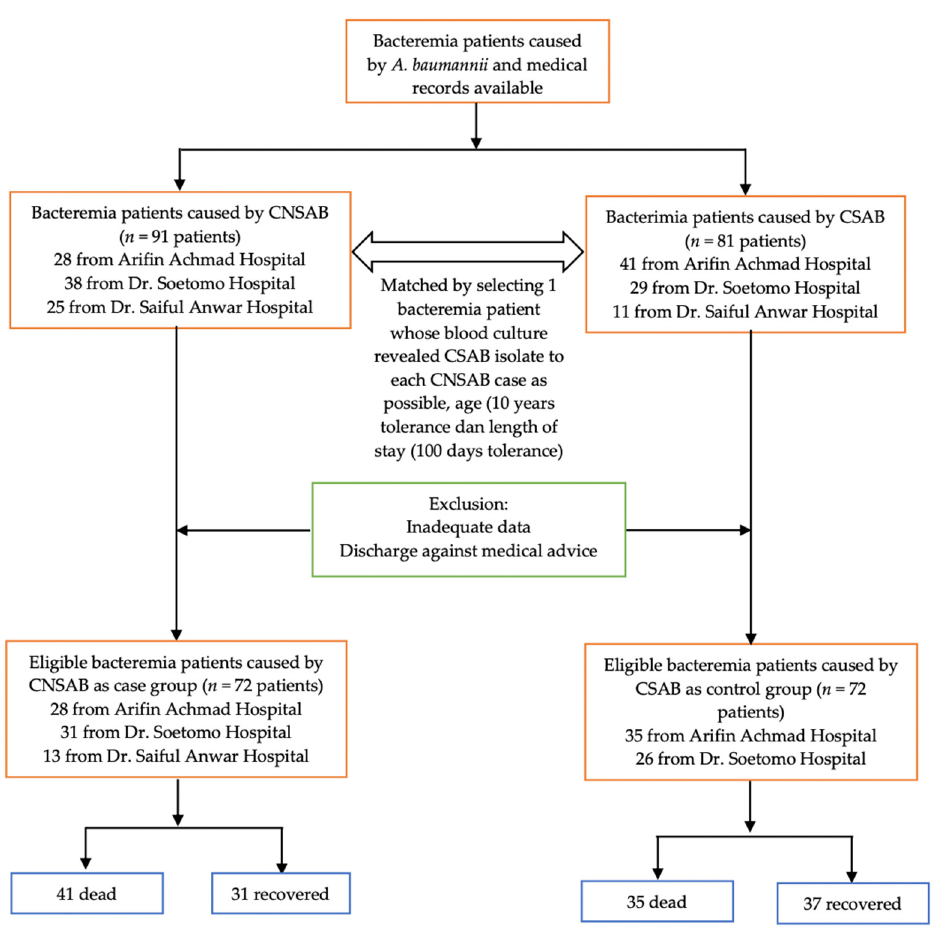
Figure 1. Flowchart of the sample selection.